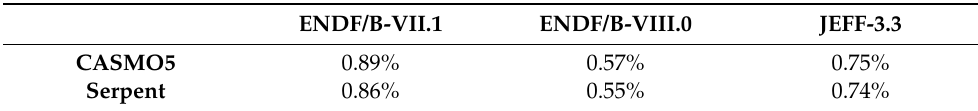
Table 1. Comparison of kinf uncertainties for various covariance sources using consistent samples in CASMO5 and